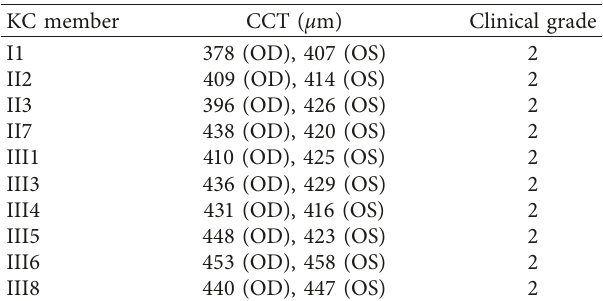
Figure 2: Corneal topography of the proband (Pentacam). OD � right eye; OS � left eye. Table 1: Clinical grades of KC members and changes in corneal thickness.